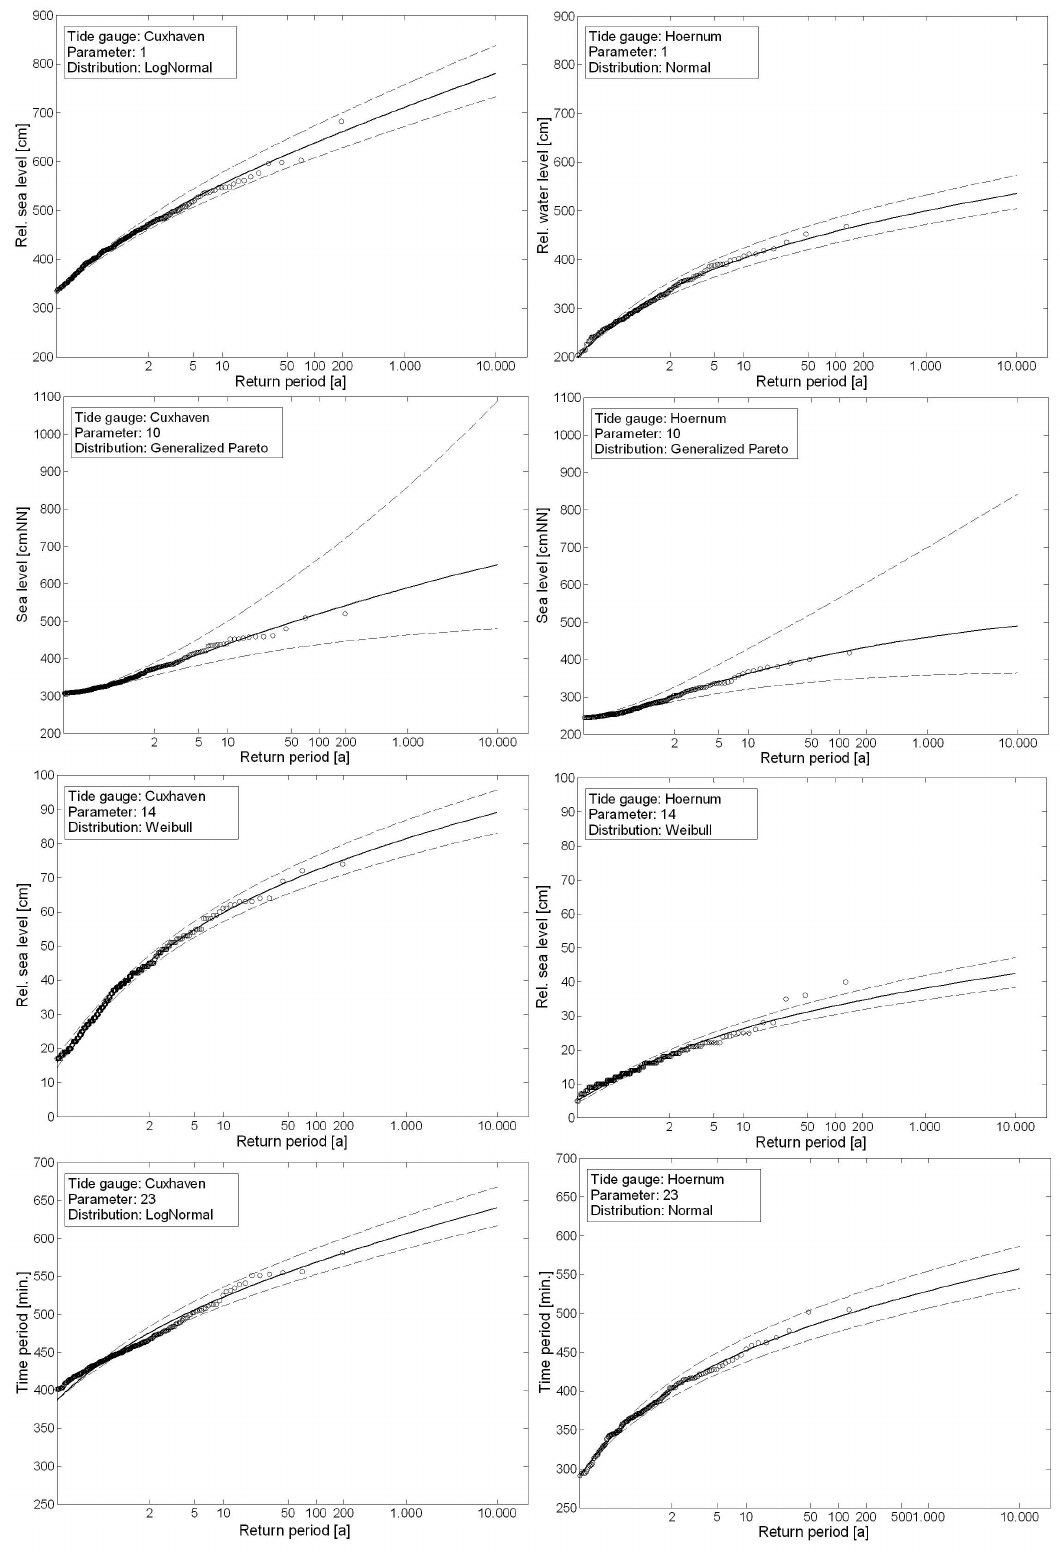
Fig. 9. Results from fitting distribution functions to selected parameter time series for the tide gauges of Cuxhaven (left) and H¨ornum